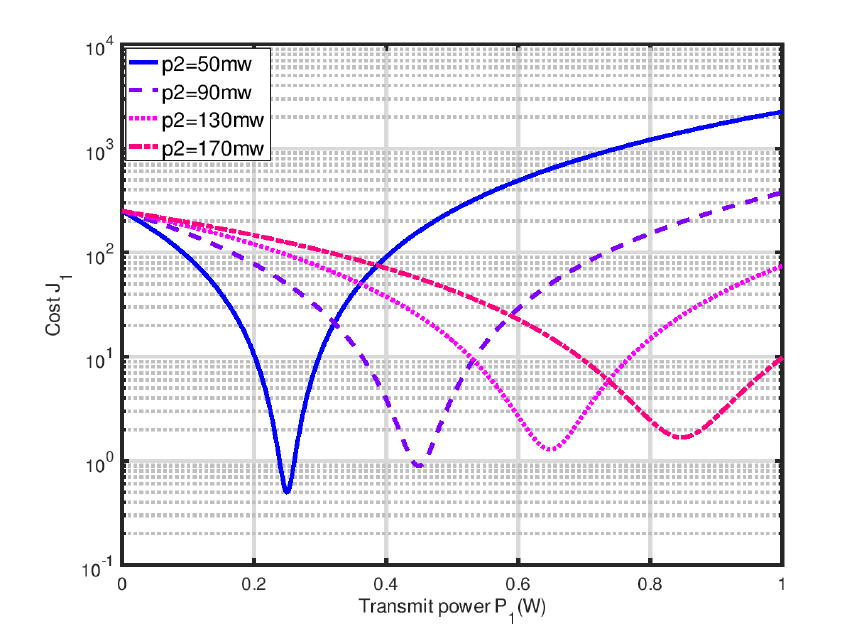
Figure 3. The Nash equilibrium of the D2D user depends on the transmit power of the cellular